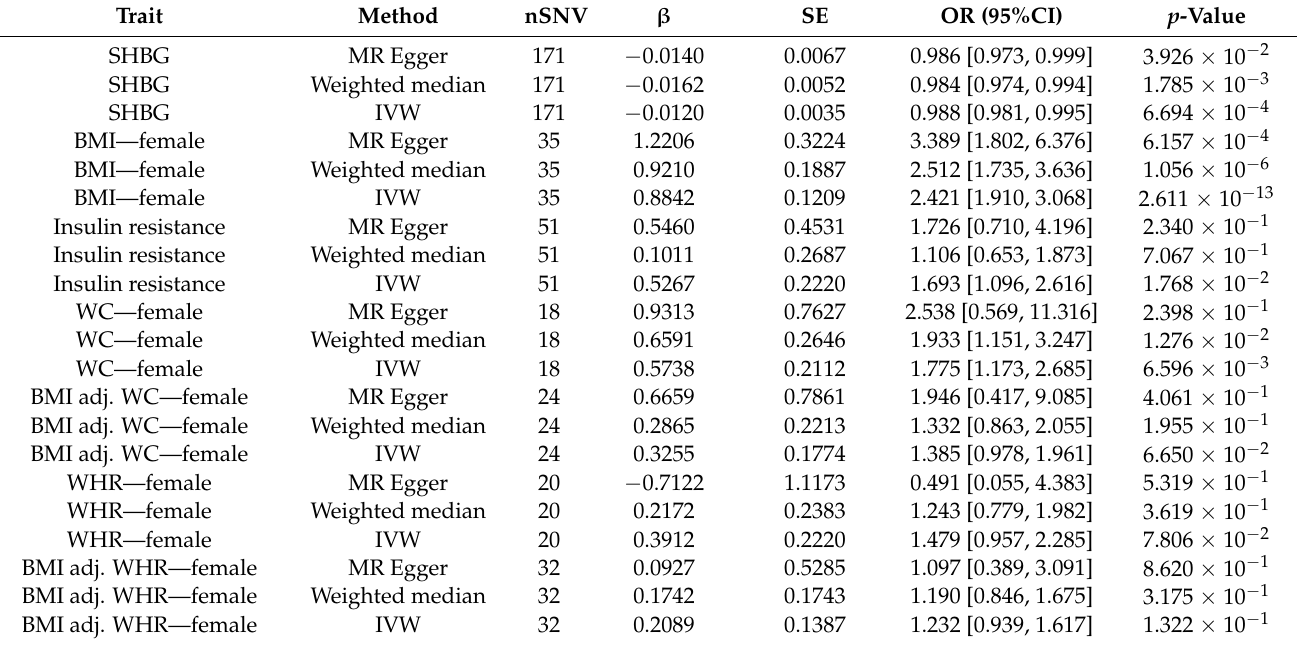
Table 2. Result of Mendelian randomization of traits on PCOS and PCOS on disease